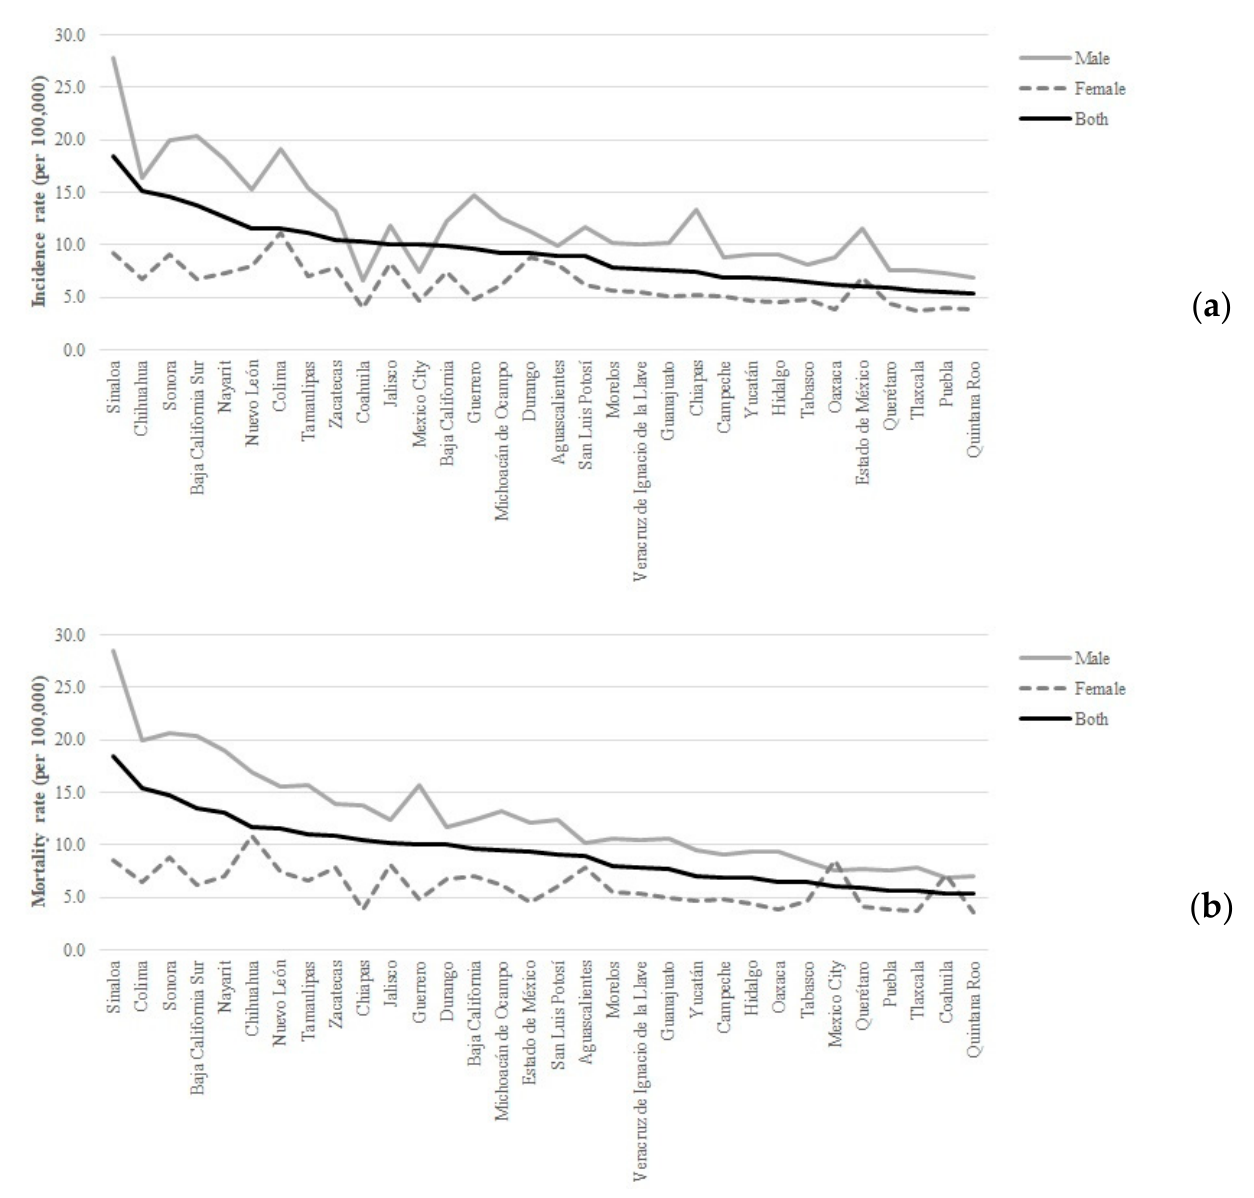
Figure 1. Sex-stratified incidence ( a ) and mortality ( b ) rates (per 100,000) due to tracheal, bronchus, and lung cancers in Mexico, 2019.